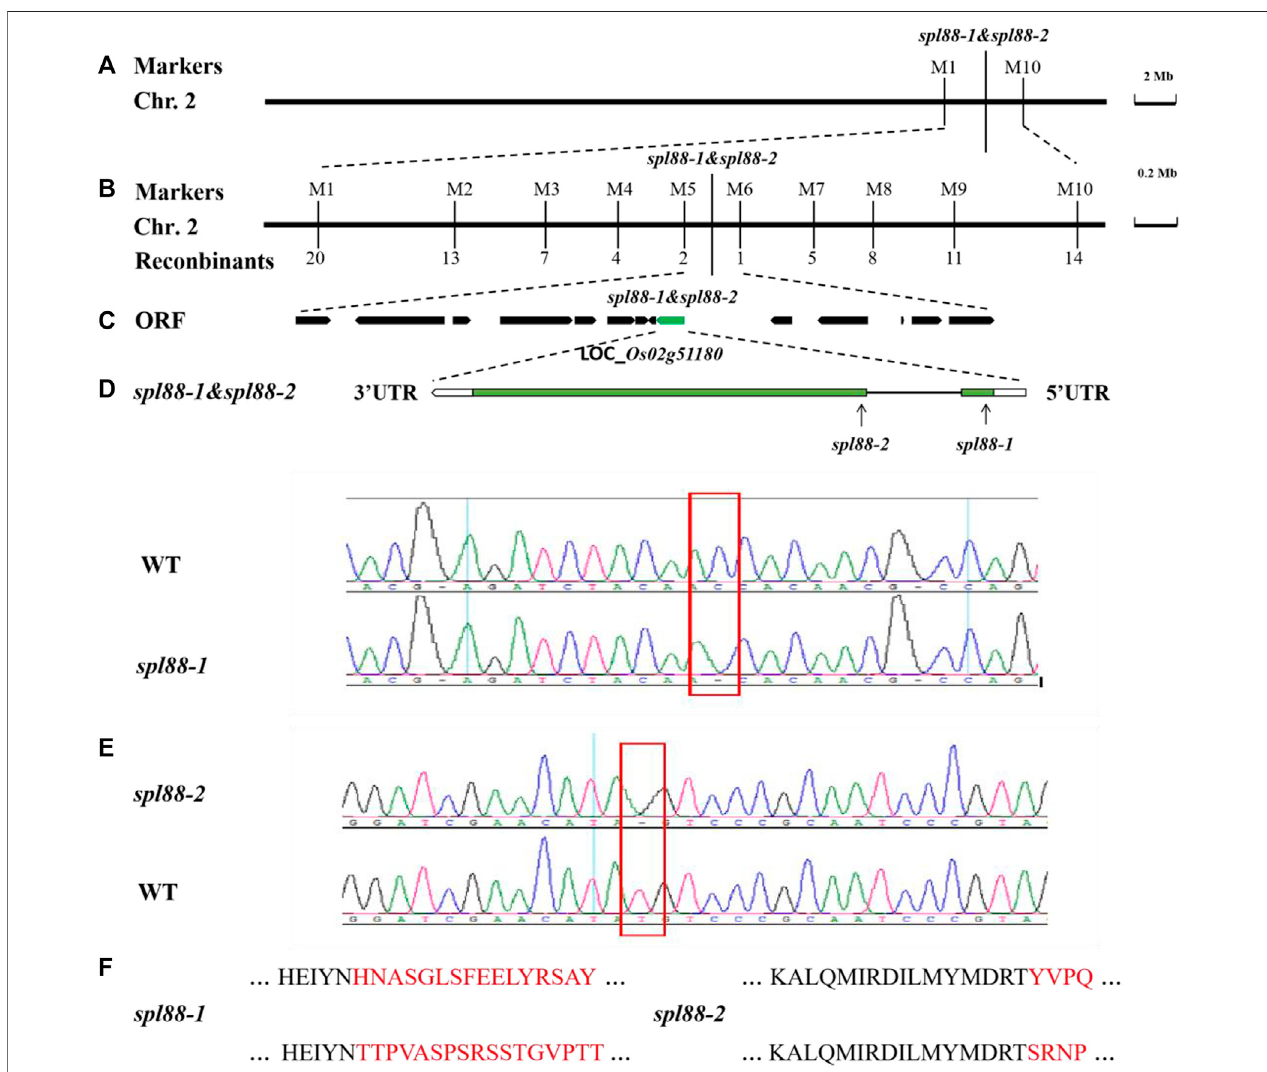
FIGURE6 | Genetic and physical maps ofthe SPL88 . (A) SPL88 gene was localized tochromosome2 between InDel markers M1 and M10; (B) SPL88 gene was delimited to the M5 to M6 interval on chromosome 2; (C) 14 putative ORFs located in the ~84 kb region of this locus; (D) gene structure of LOC_Os02g51180 ; (E) sequenceanalysisofC-basedeletion mutationsitesinwild-type and spl88-1 ;sequenceanalysisofT-base deletion mutationsitesinwild-typeand spl88-2 ; (F) mutation causes premature termination of protein